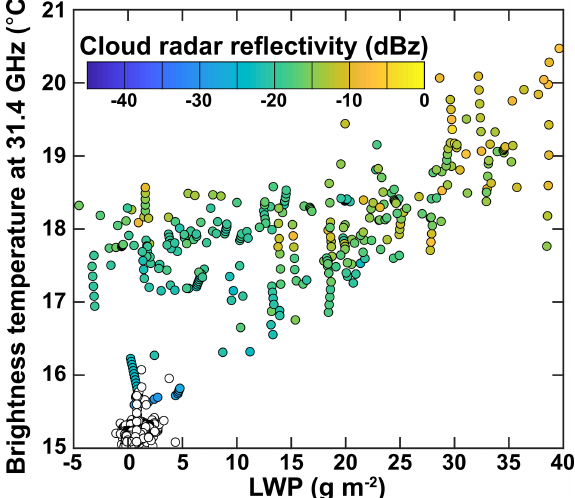
Figure 3. Scatter plot of the change in brightness temperature at 31.4GHz with LWP as measured by the MWR. Colour coding refers to the maximum in cloud radar reflectivity in decibels for the respective profile. The data cover the time period from 11:00 to 17:00UTC on 25 July 2014 as in Fig. 2. White circles refer to cloud-free